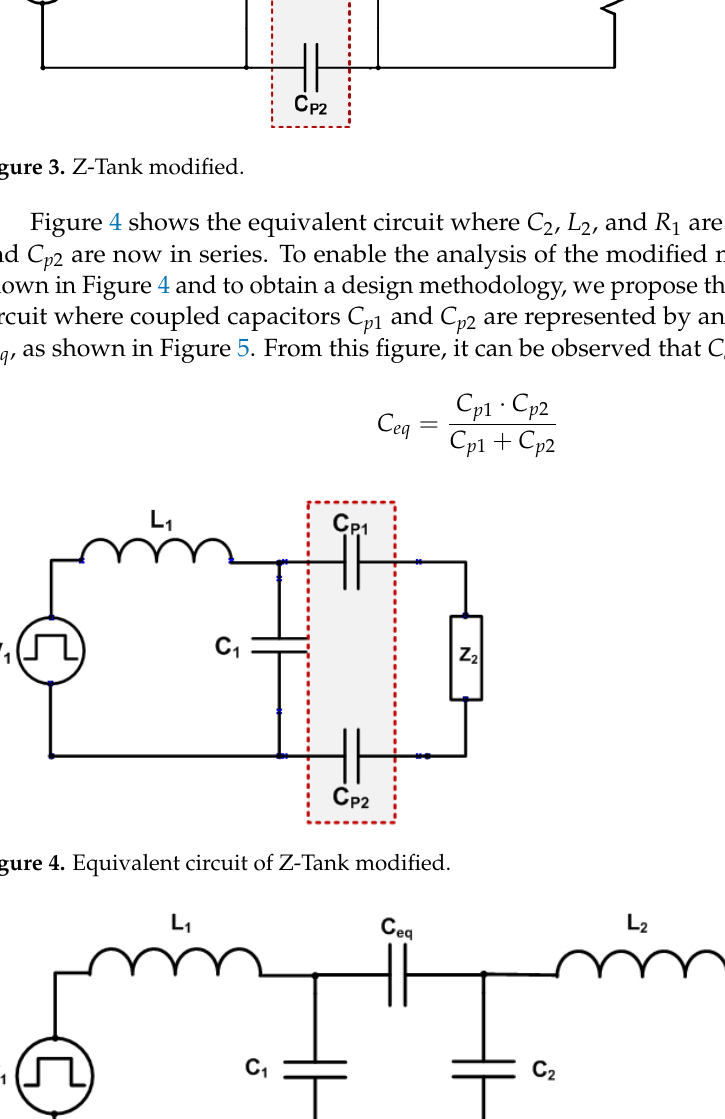
Figure 3. Z-Tank modified.